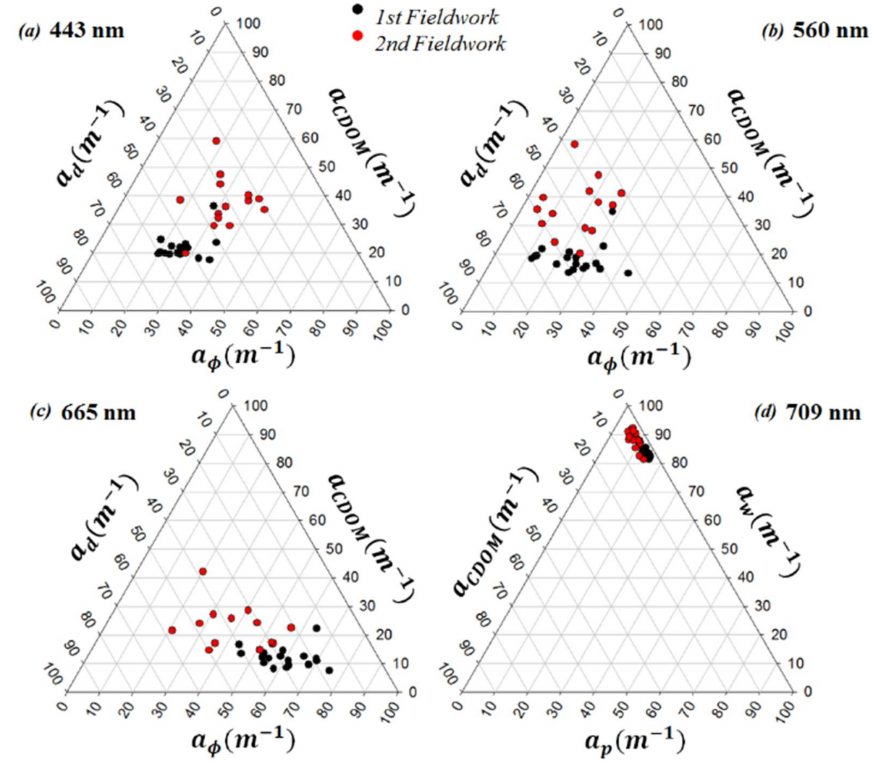
Figure 2. Ternary plots displaying the relative contribution of absorption of colored dissolved organic matter (CDOM) ( a CDOM ), phytoplankton ( a φ ) and detritus ( a d ) to the total absorption at different wavelengths of ( a ) 443 nm, ( b ) 560 nm, ( c ) 665 nm and ( d ) the relative contribution of water ( a w ), particulate ( a p ) and CDOM to the absorption at 709